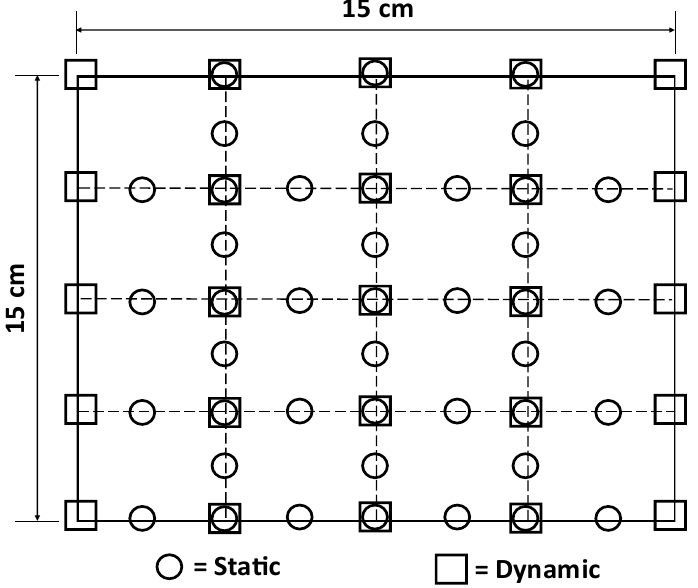
Figure 2. Schematic representation of the over-layer grid system used for analysis on the substrate plane. Note that the dashed line is the “over-layer grid system” and only a guide to the eye for the profilometry measuring points.